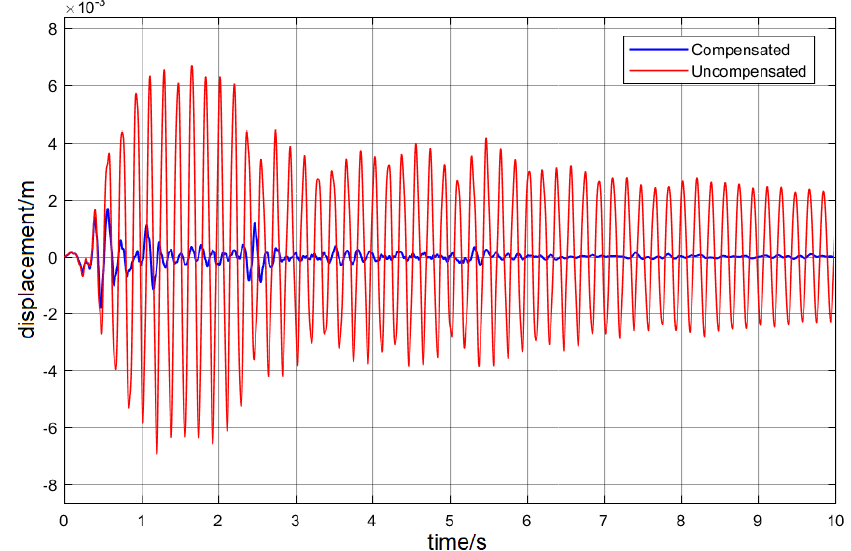
Figure 7. Comparison between the displacement signal of an uncompensated building versus a compensated one with a PSO-tuned BEL controller.